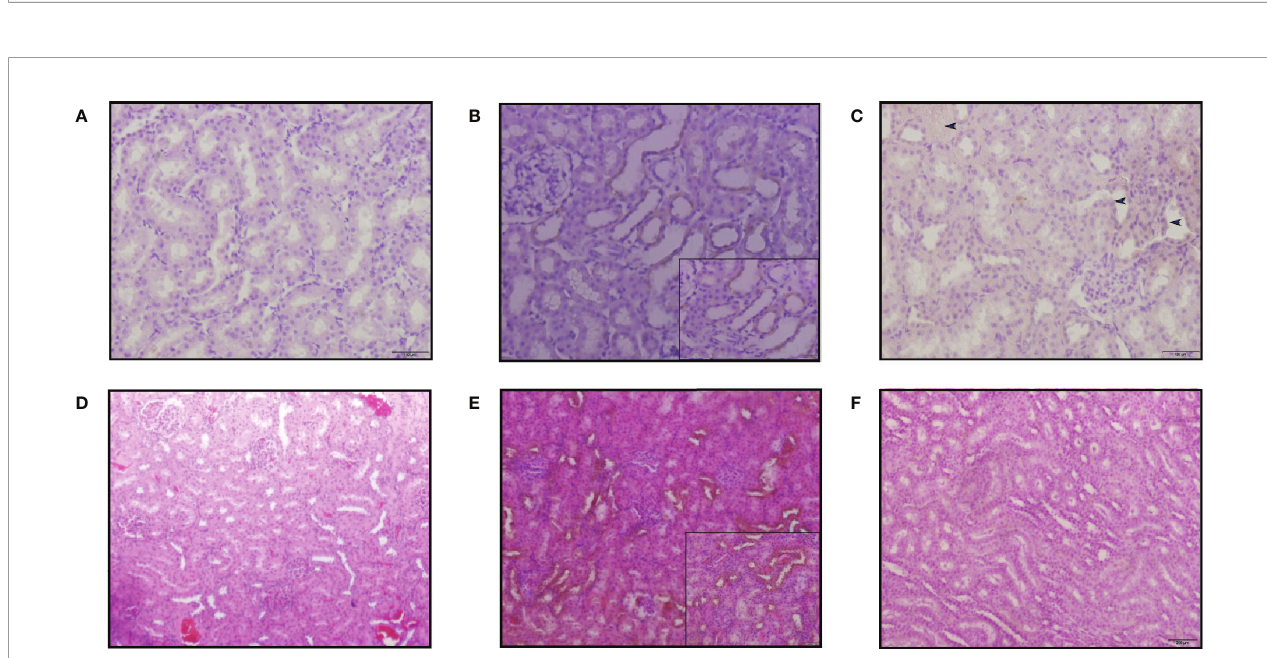
FIGURE 8 | Kim-1 and CLU immunoreactivity in the kidneys of SD rats treated with a single intravenous dose of 15mg/kg/day BW for 5 days. In Kim-1 immunoreactivity was shown in, (A) vehicle, (B) AmB and (C) SM21. Only occasional Kim-1-positive tubules were detected in SM21 (blue arrow in C) kidneys. Kim-1 was prominently detected translocated to an apical (luminal) membrane of convoluted portion of the proximal tubules in AmB group. In CLU immunoreactivity was shown in, (D) Vehicle (E) AmB, (F) SM21. In AmB group, high expression of CLU observed over almost all different tubules. Positive pixel analysis identi fi ed a low increase in immunoreactivity in rats dosed with SM21 group compared to control. However, this expression is comparatively lower than AmB treatment. No immunoreactivity of Kim-1 and CLU were detected in vehicle group. IHC pro fi ler was used to assign an automated score to the respective IHC images by computerized pixel pro fi ling based on colour deconvolution acquired on Image J. Kim-1, Kidney injury molecule-1; CLU, Clusterin; SD, Sprague Dawley; IHC,